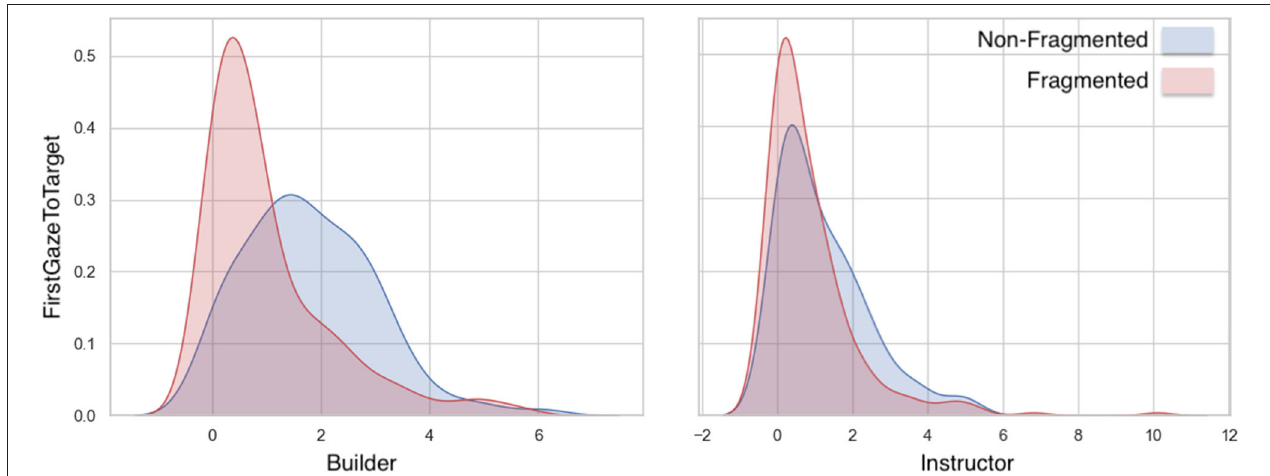
FIGURE 5 | Differences in variance of FirstGazeToTarget measure among fragmented and non-fragmented instructions.